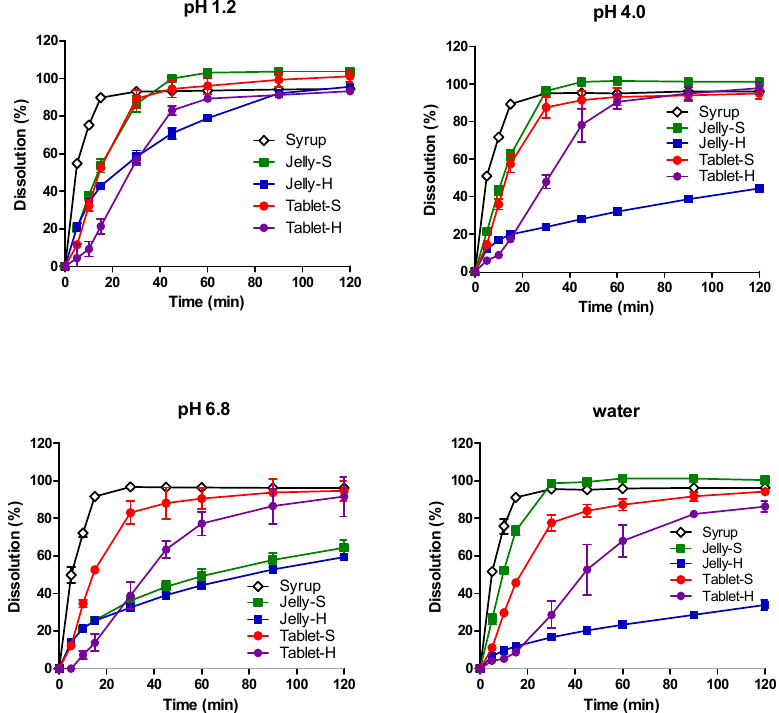
Figure 3. Dissolution profiles of dextromethorphan hydrobromide from various formulations in pH 1.2, 4.0, 6.8, and water at 37 °C. Each point represents mean ± standard deviation ( n = 6).